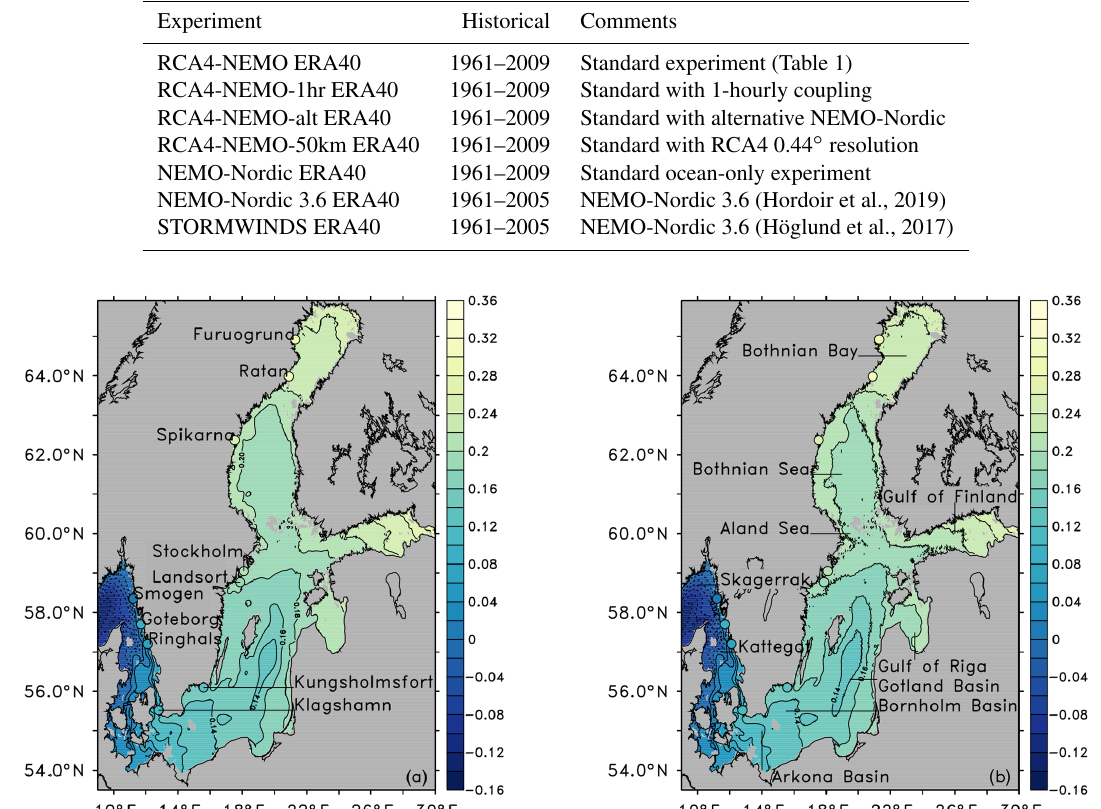
Figure 1. Mean sea level (m) for the period of 1970 to 1999 for the hindcast RCA4-NEMO ERA40 (a) and the ensemble mean of the GCMs listed in Table 1 (b) . The colored dots indicate MSL estimated from long-term tide gauge observations (WISKI, 2017).